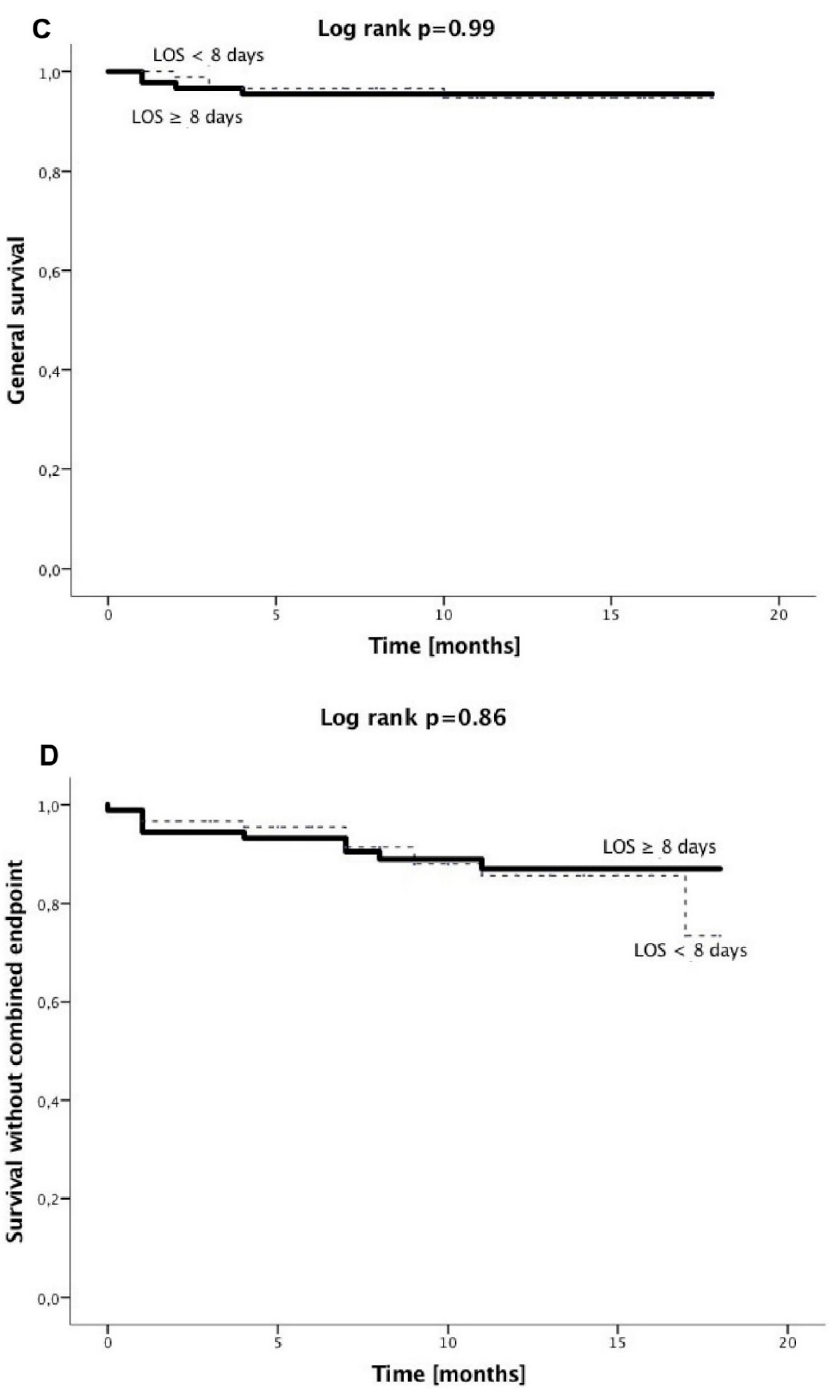
Figure 3. Kaplan–Meier survival analysis for general survival, and survival without combined endpoint in relation to risk ( A , B ) and hospitalization length categories ( C , D ).